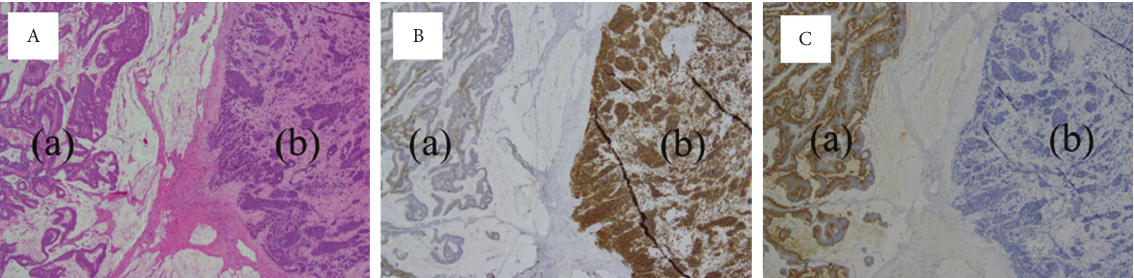
Figure 4: Histopathological and immunohistochemical findings of the resected transverse colon tumor. (A) The tumor was composed of well-differentiated adenocarcinoma (a) with poorly differentiated neuroendocrine carcinoma (b) and H&E staining at low power. (B) Immunohistochemistry showed that synaptophysin was partially positive in the adenocarcinoma component (a) and positive in the NEC component (b) at low power. (C) Immunohistochemistry showed that CEA was positive in the adenocarcinoma component (a) but negative in the NEC component (b) at low